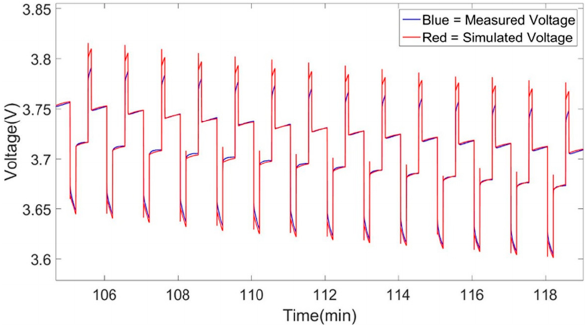
Figure 17. Error of the 2nd order Thévenin model measured and simulated DDP comparison at 25 °C with Coulomb counting and advanced characterization. Energies 2016 , 9 , 360